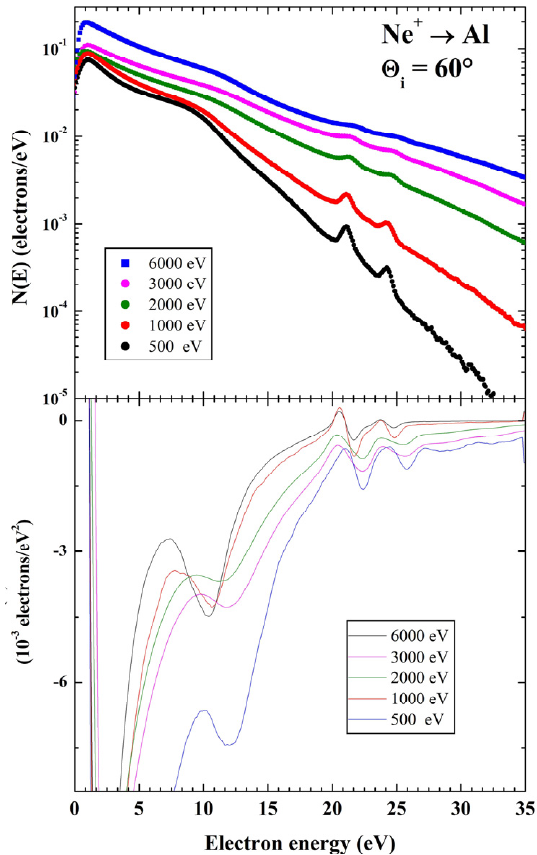
Figure 4. ( Top ): energy spectra N(E) of electrons emitted from an Al surface by Ne + ions as a function of ion incident energy. The spectra have been acquired with the large acceptance angle spectrometer for an incident angle of 60°. The spectra have been normalized to the total electron emission yields. ( Bottom ): derivative of the spectra that improve the visualization of the plasmon feature, showing the transition from potential excitation of surface plasmons to bulk plasmons excitations.